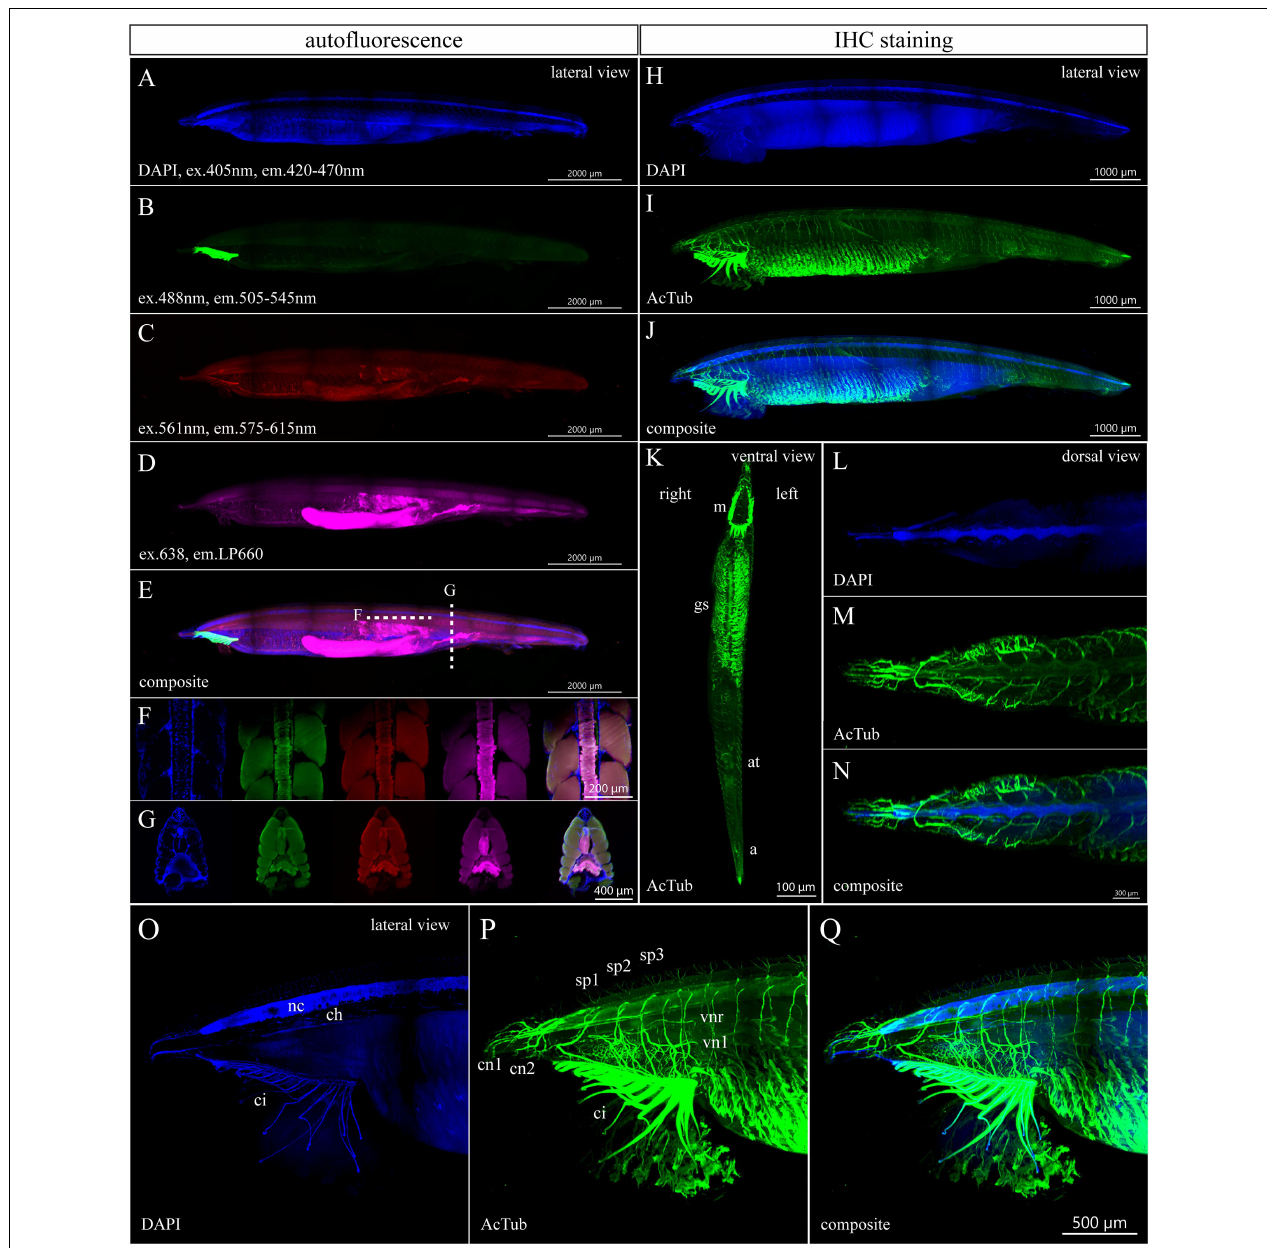
FIGURE 4 | Autofluorescence and anti-acetylated- α -tubulin staining of a 6-month-old amphioxus juvenile. (A) DAPI staining of a 6-month-old juvenile with a length of 10.5 mm. (B–E) Autofluorescence of the same individual emitted in green (B) , red (C) , and magenta channels (D) . (E) Composite image from the lateral view. (F,G) Subset of horizontal (F) or transversal (G) optical slices of the specimen from (A–E) in the area with notochord showing the DAPI staining and autofluorescence in green, red, and magenta channels with a composite of all above images (from left to right). (H–Q) IHC staining of acetylated tubulin of a 6-month-old juvenile with a length of 9.7 mm shown as whole mount (H–K) or individual portion of the body (L–Q) . Detail of the anterior portion of juvenile body after removal of optical slices containing buccal cirri, (O–Q) detail of the anterior juvenile body part from the left side view. The regular areas of low signal intensity in the images are caused by lower light intensity falling on the camera chip margins during the imaging of the tiles. a., anus; at., atrioporus; ci., buccal cirri; ch., notochord; c.n.1/2, first and second cranial nerve; g.s., gill slits; m., mouth; n.c., neural cord; sp.1/2/3, first, second, and third spinal nerves; v.n.l./v.n.r., nerve to the left/right side of the velum. Individual channels were imaged sequentially in the track switch mode—z-stack.